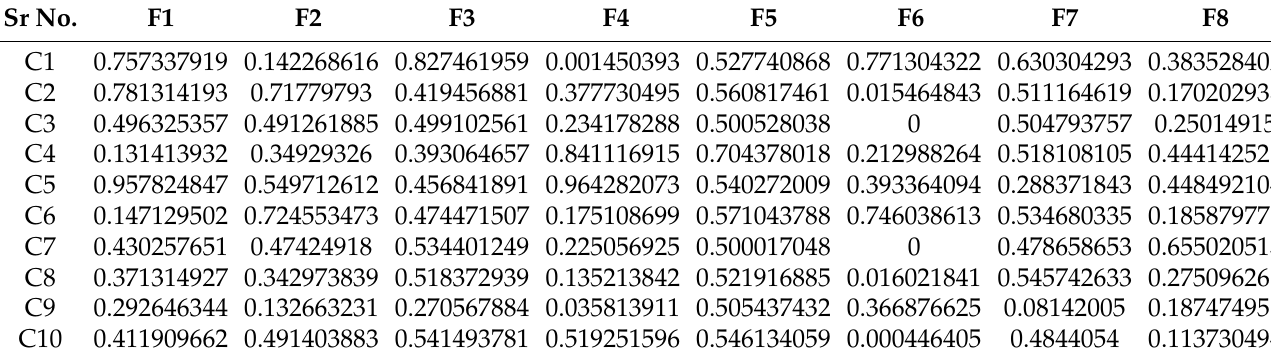
Table 21. The best centroids for Yeast obtained by proposed